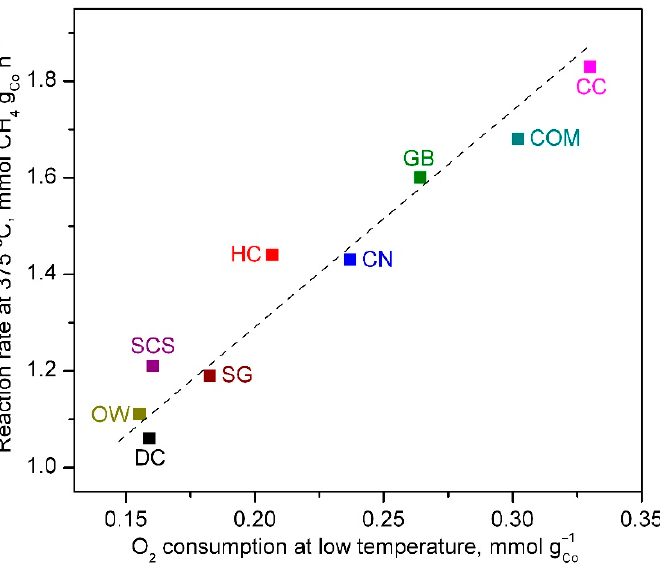
Figure 9. Relationship between reaction rate and the specific O 2 consumption at low temperature derived from the CH 4 -TPRe runs.